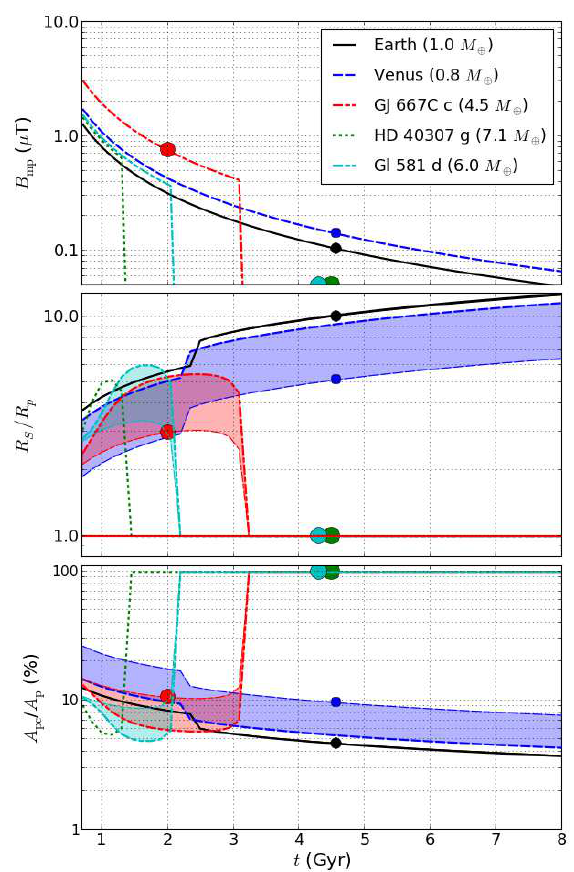
Figure 17. Evolution of magnetospheres. Shaded regions are limited by the properties calculated at a minimum period of rotation of P ≈ 1.0 day (upper and lower bounds in standoff radius and polar cap area curves respectively) and the maximum period of rotation P ≈ P o corresponding to a perfect match between the rotation and orbital periods (tidal locking). The actual curves should lie inside the shaded regions probably closer to the lower (upper) limits in the case of close-in already tidally locked planets (including